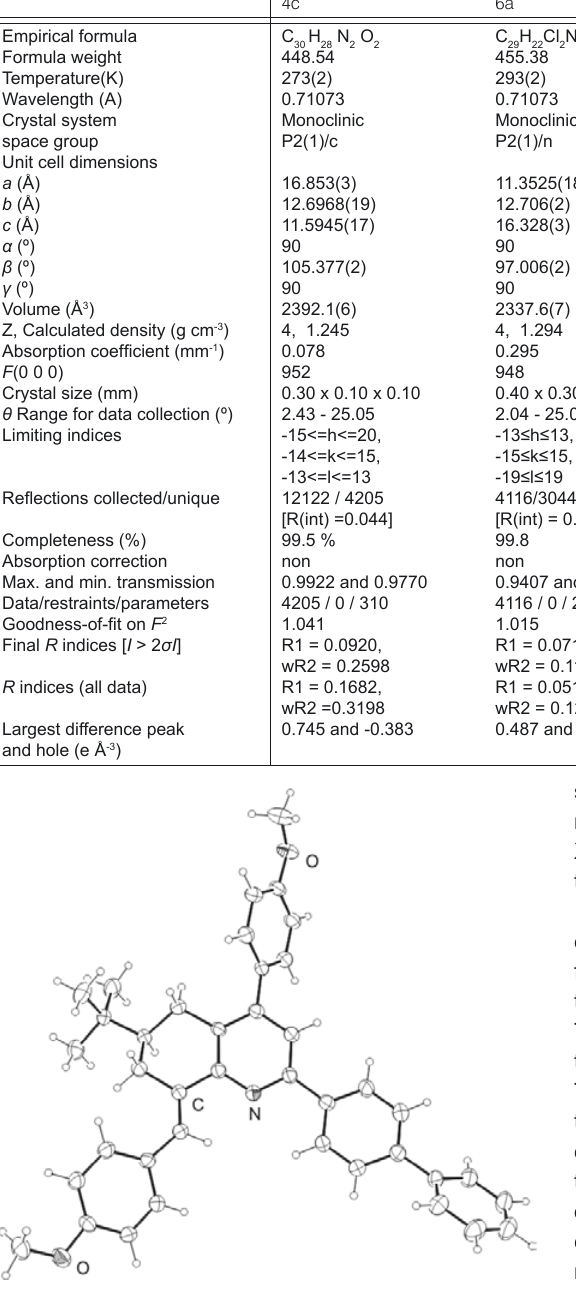
Figure 4. Molecular structure of the compound 7h with 30% prob- ability